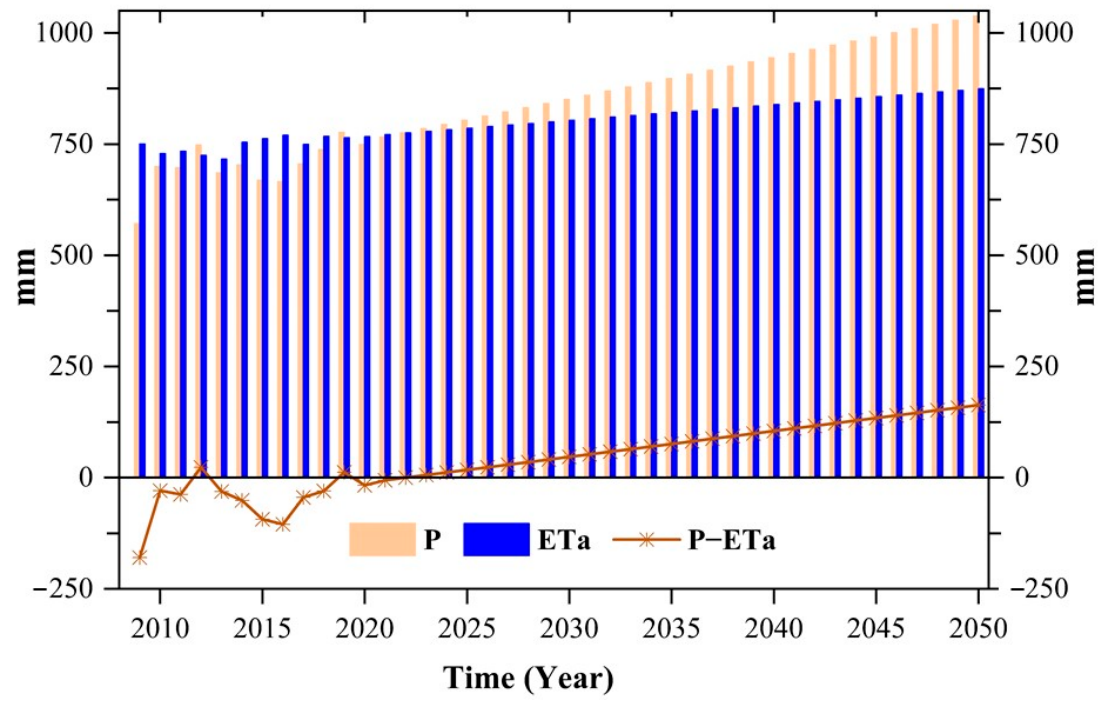
Figure 6. Comparison of yearly average variation of precipitation (P), ETa, and P − ETa in the NRB for the period 2009–2050.